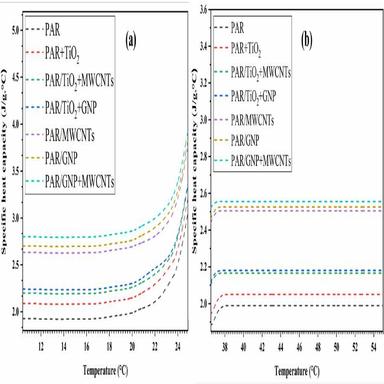
Specific heat capacity of paraffin and nano-PCMs versus temperature (a) in a solid phase and (b) in a liquid phase.